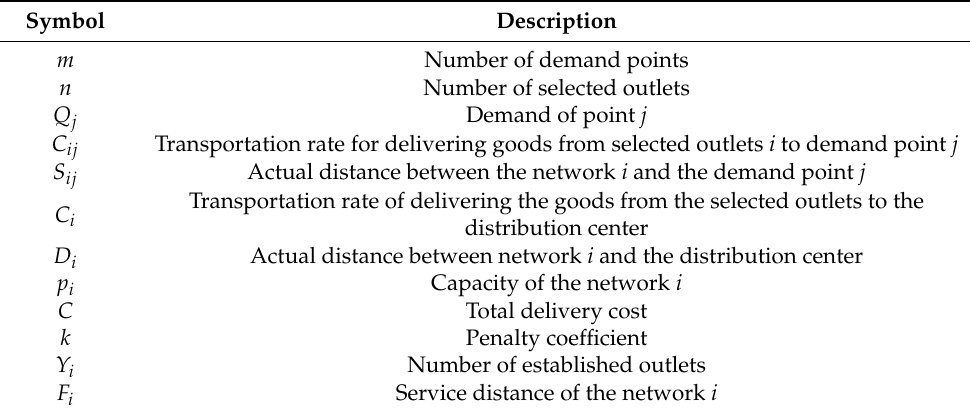
Table 1. Model symbol description. Symbol Description m Number of demand